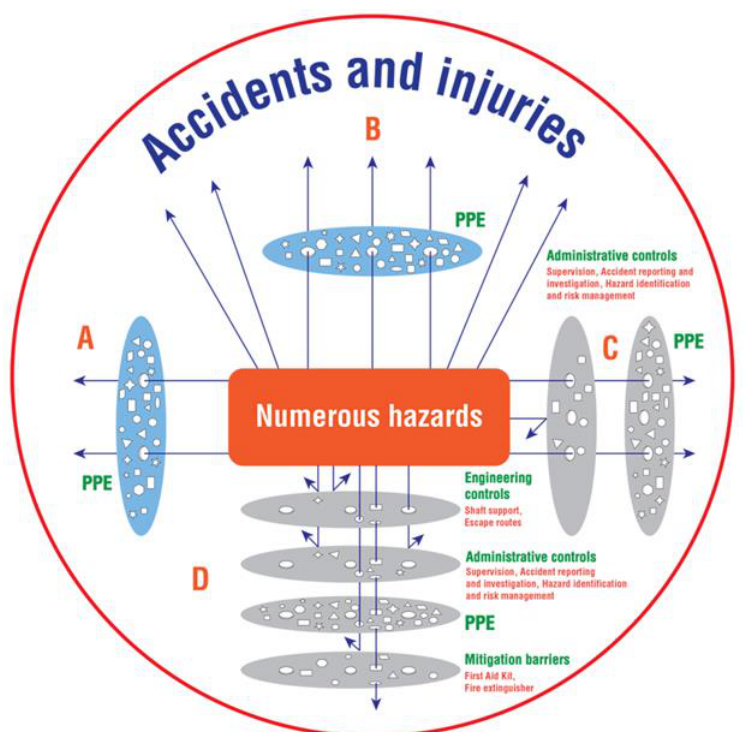
Figure 1. Numerous hazards and successive defensive layers: Risk management and accident prevention in ASGM in Zimbabwe modified after [12]. Key: High exposure to hazards: A and B; Single layer of control measures, e.g., PPE; Reduced exposure to hazards: C; Double layer of control measures, e.g., PPE, administrative controls; Comprehensive protection: D; Successive layers of control measures, e.g., engineering controls, administrative controls, PPE, and mitigation barriers.